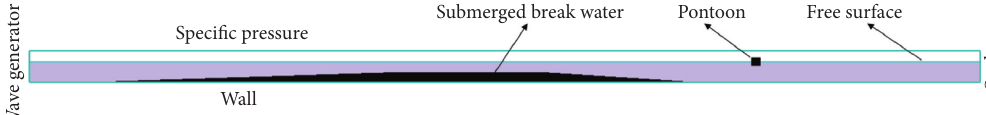
Figure 1: Schematic boundary conditions for the numerical wave